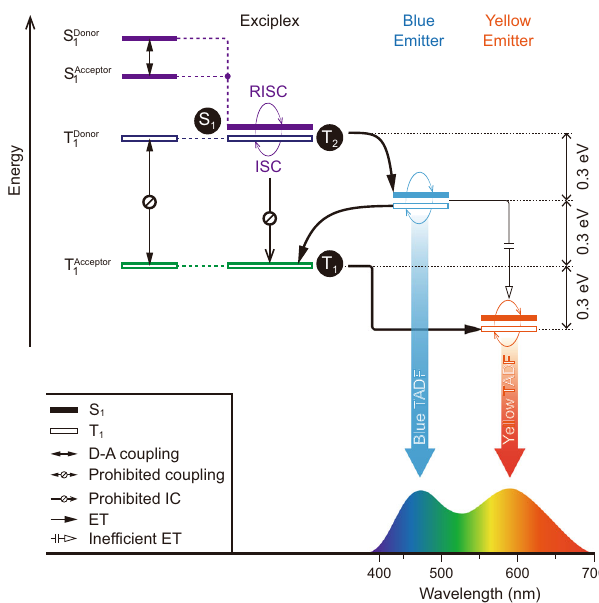
Fig. 1 Proposed energy-relaying mechanism. Exciton allocation in single- emissive-layer, TADF WOLEDs comprising a D – A exciplex host, a blue emitter, and a yellow emitter. Inef fi cient energy transfer occurs from the exciplex host to the blue emitter and subsequently to the yellow emitter, due to a large energy gap between the blue and yellow emitters (~0.6 eV). The proposed exciplex, based on a high triplet donor and a low triplet acceptor, generates a large triplet gap between a high-lying T 2 and a low- lying T 1 . This design enables ef fi cient ladder-like (~0.3 eV ladder spacing) triplet energy transfer from T 2 → blue emitter → T 1 → yellow emitter. ET, IC, ISC, and RISC refer to energy transfer, internal conversion, intersystem crossing, and reverse ISC,